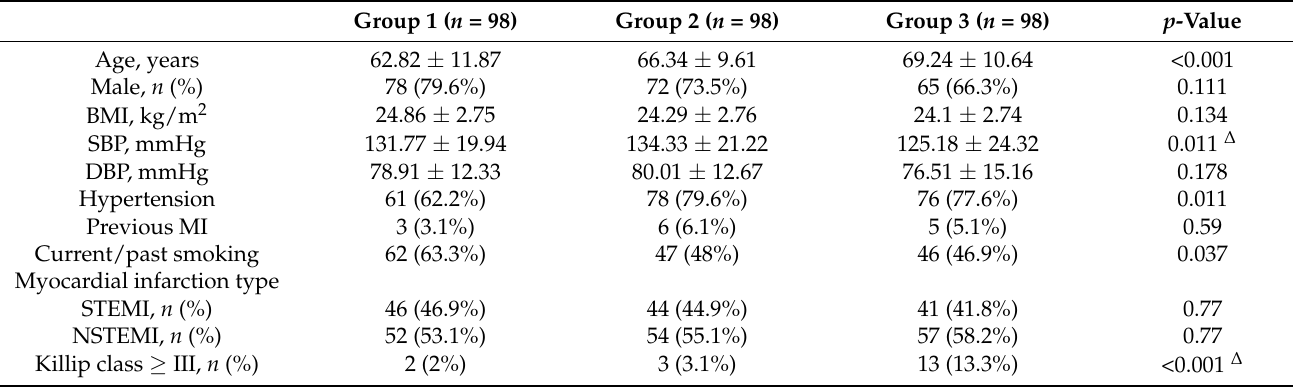
Table 1. Demographic variables and baseline clinical characteristics.